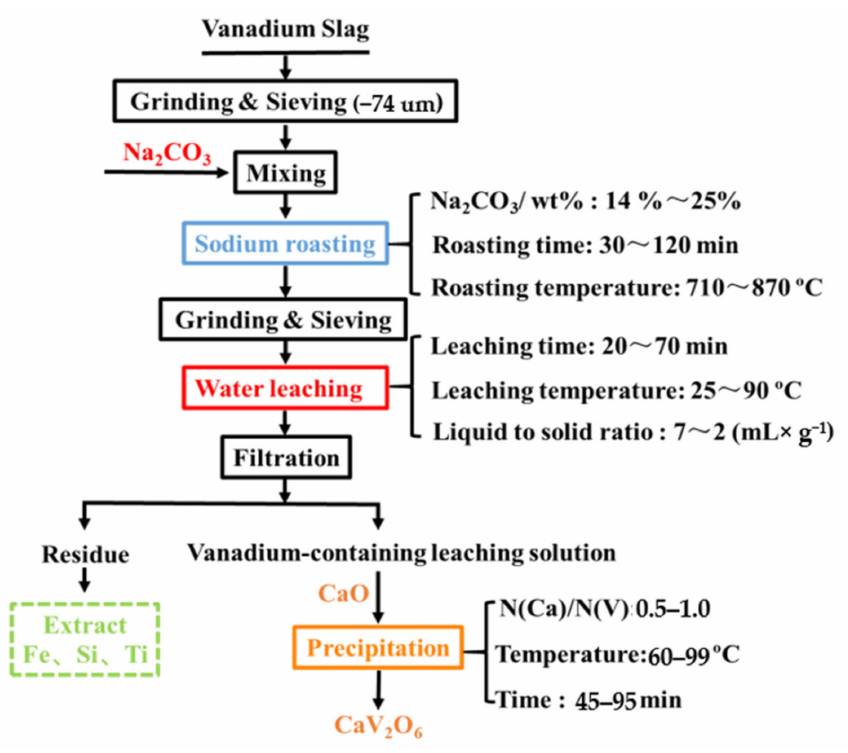
Figure 1. Flow chart of the whole